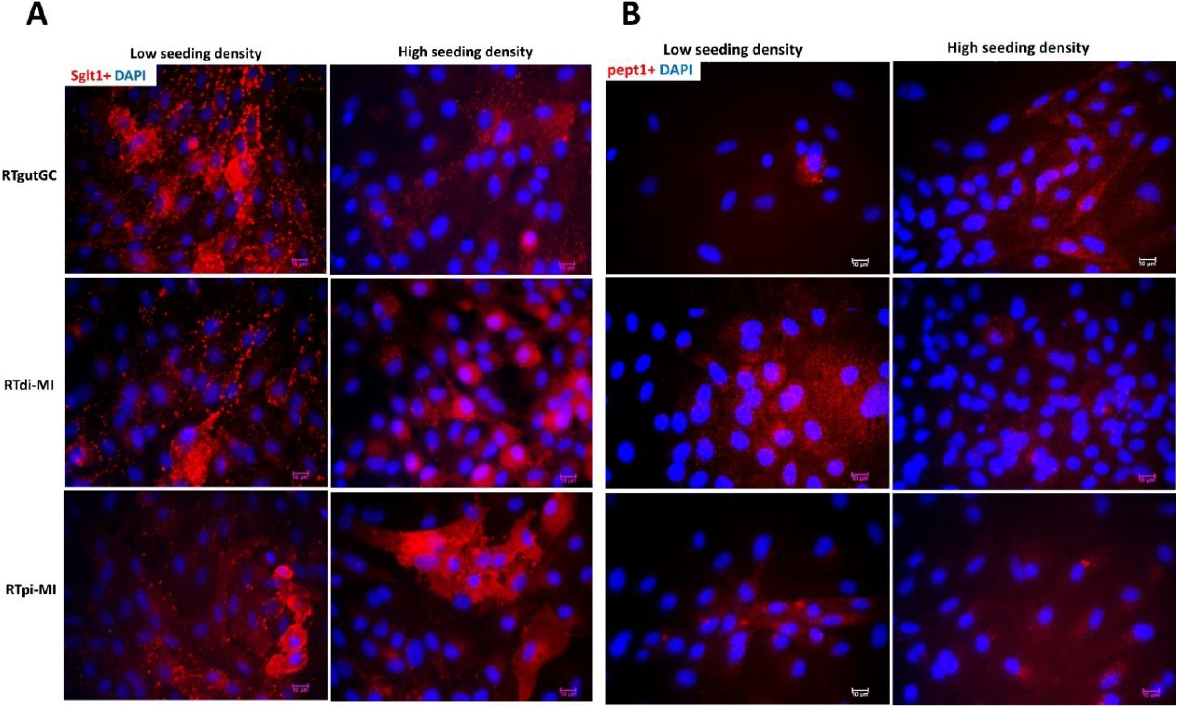
Figure 6. Protein expression of Sglt1 (( A ), red) and Pept1 (( B ), red) was not affected by cell seeding density. DAPI was used to stain cell nucleus. Scale bar, 10 µm.